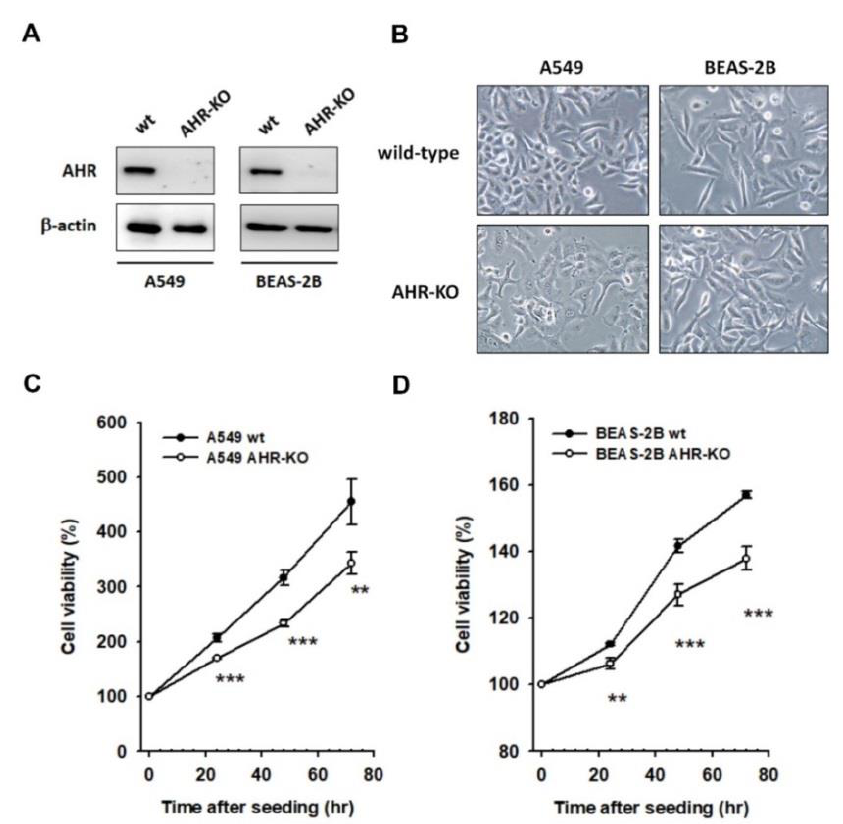
Figure 1. The AHR-KO clones were distinguishable to their wild-types, either in cell morphology or in cell proliferation curves. The AHR-KO cells of A549 and BEAS-2B were built by using the CRISPR/Cas9 system as described in Materials and Methods. Their expression level of AHR was affirmed by Western blotting ( A ) and cell morphology was imaged (200x) ( B ). A round cell shape with abundant nucleoli was featured in AHR-KO clones. By using MTT assay, the cell doubling time was significantly prolonged in AHR-KO clones of A549 ( C ) and BEAS-2B ( D ), compared to that of wild-type cells. (** p < 0.01, *** p < 0.001, indicates statistically significant difference from the wild-type).